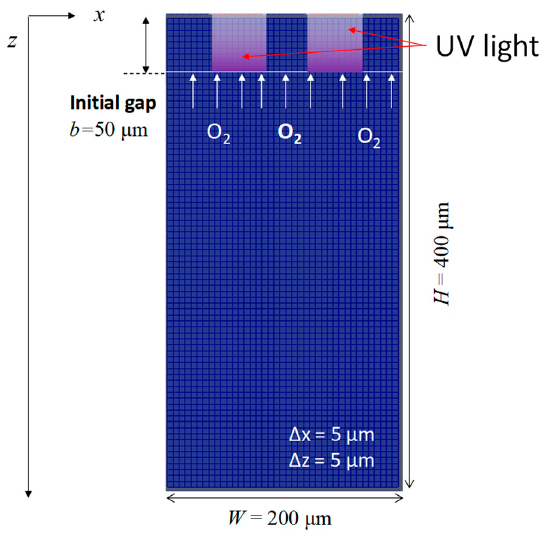
Figure 1. Geometry of numerical simulation.